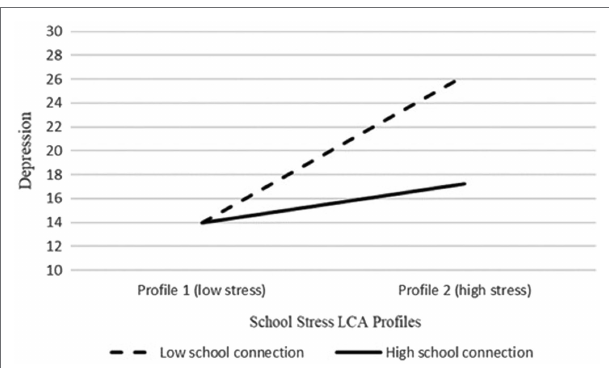
FIGURE 1 | The relation between school stress LCA profiles and depression scores across the high (+1 SD ) and low (–1 SD ) school connection groups in the Tayal